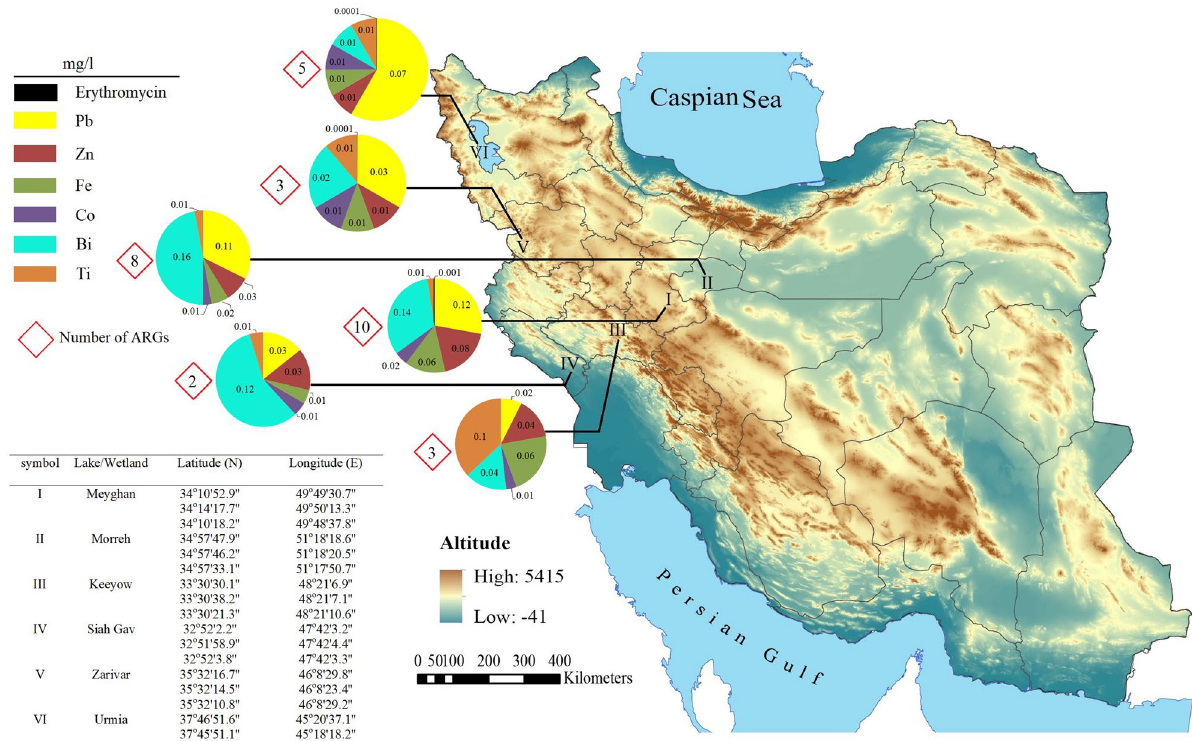
Figure 1. Location, altitude, number of resistance genes, and heavy metals and erythromycin concentration of studied aquatic ecosystems. ArcGIS Desktop 10.8.2 was used to draw the map (https:// suppo rt. esri. com/ en/ produ cts/ deskt op/ arcgis- deskt op/ arcmap/